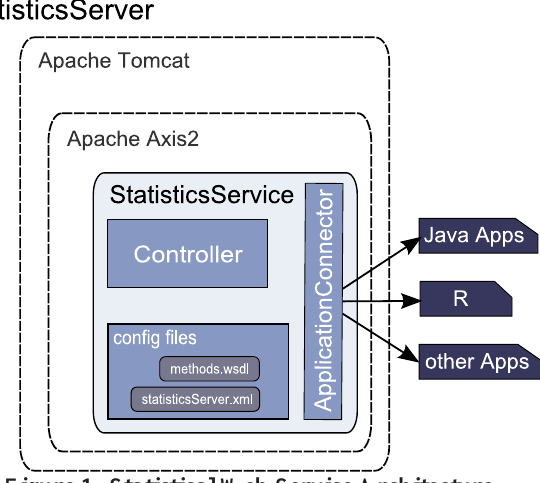
Figure 1: Statistical Web Service